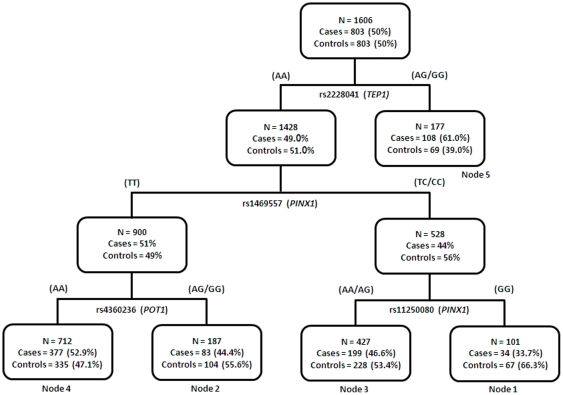
The tree structure of the CART analysis of interaction effects between the 18 top variants (P<0.05,
Table 2
) in modulating bladder cancer risk.